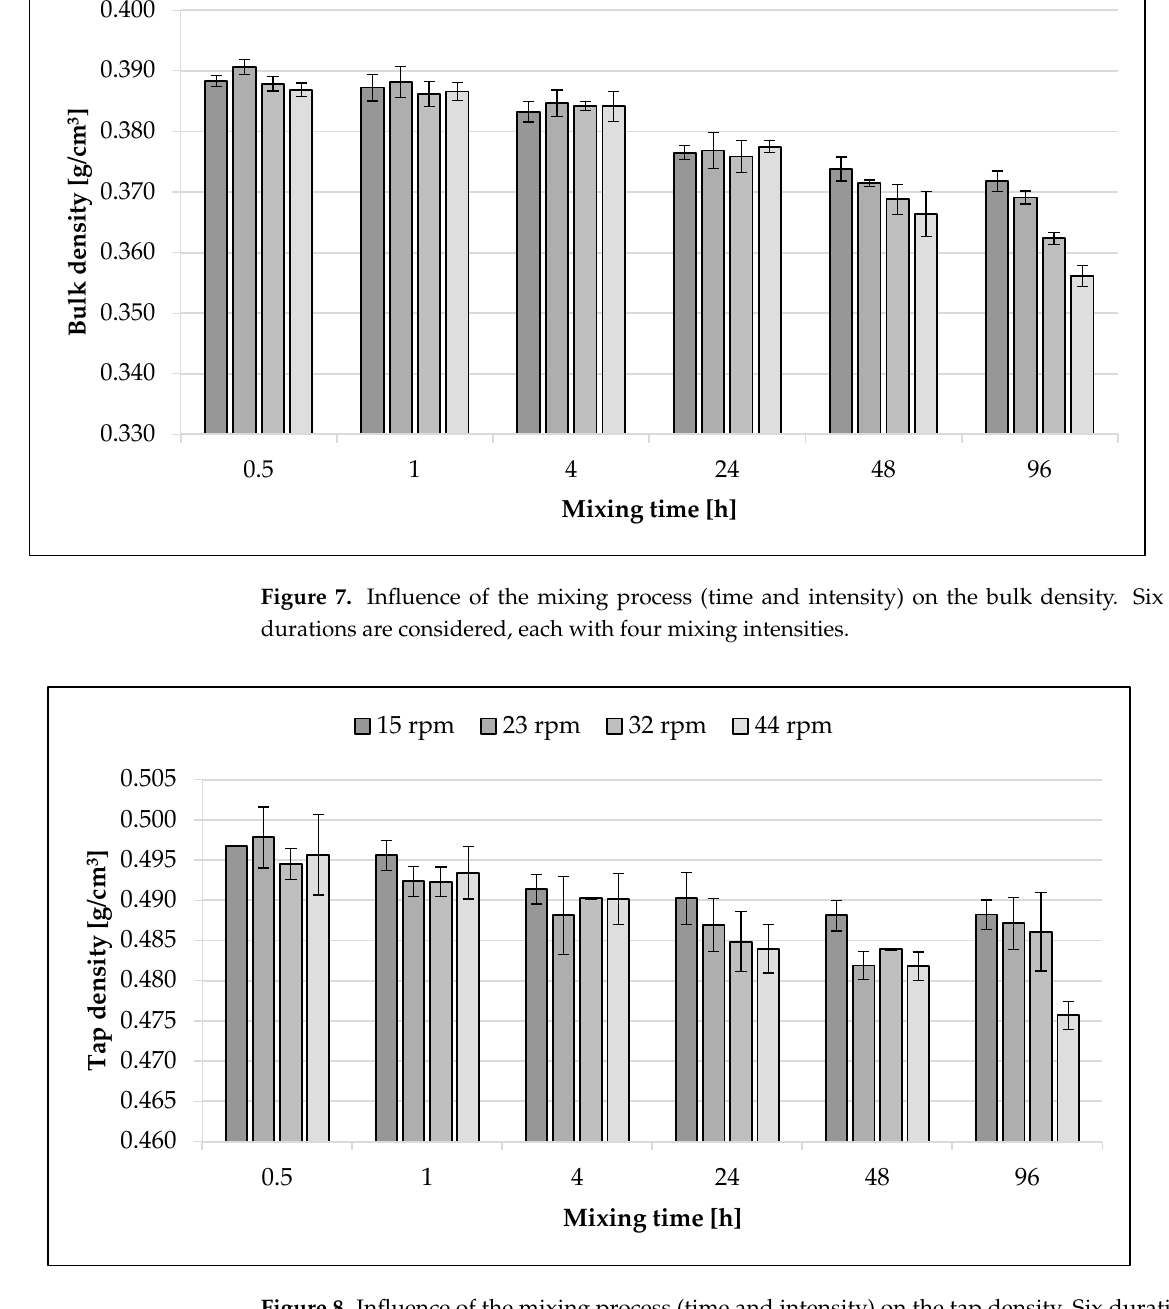
Figure 8. Influence of the mixing process (time and intensity) on the tap density. Six durations are considered, each with four mixing intensities.